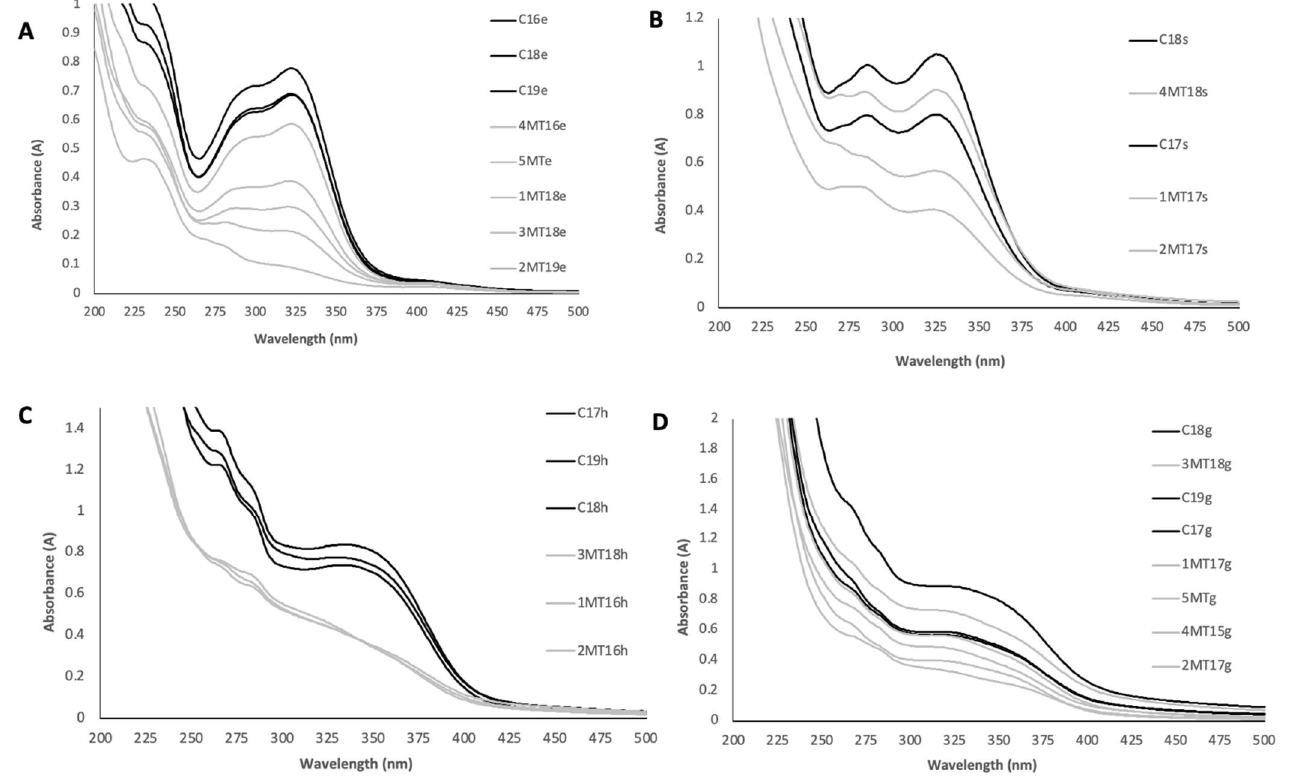
Figure 2. Spectrophotometric UV–Vis analysis of analyzed commercial mother tinctures of Echinacea purpurea ( A ), Salvia officinalis ( B ), Hypericum perforatum ( C ), and Ginkgo biloba ( D ). Names of extracts in the legends are ordered in descending intensity of maximum absorption.